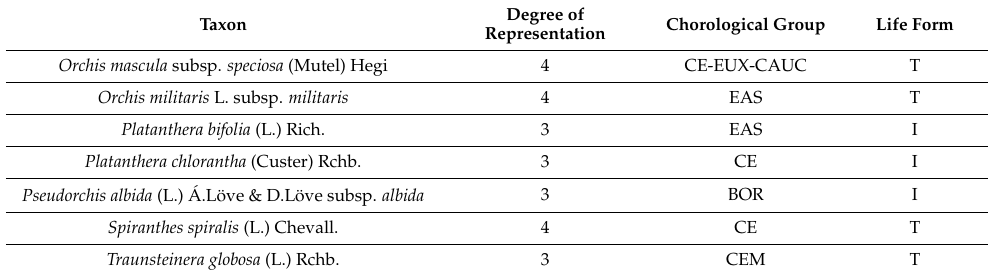
Table 1. Cont. Taxon Degree of Representation Chorological Group Life Form Orchis mascula subsp. speciosa (Mutel) Hegi 4 CE-EUX-CAUC